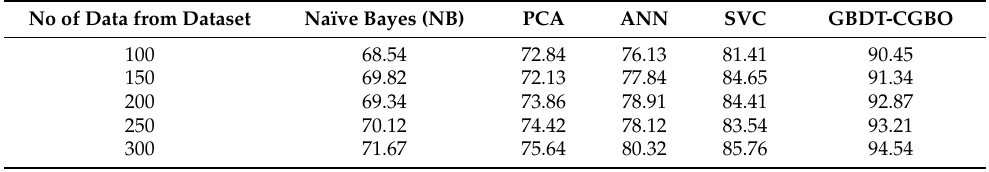
Table 2. Recall Analysis of GBDT-CGBO method with existing system in percentage.